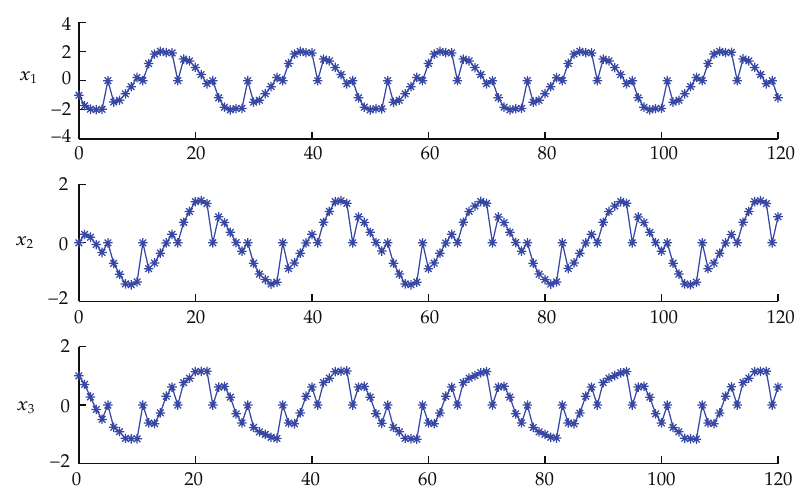
Figure 2: State responses of the discrete-time neural networks with initial conditions (cid:2) x 1 (cid:2) s (cid:3) ,x 2 (cid:2) s (cid:3) ,x 3 (cid:2) s (cid:3)(cid:3) T (cid:8) (cid:2) − 1 , 0 , 1 (cid:3) T , s ∈ N (cid:5) − 3 , 0 (cid:6)